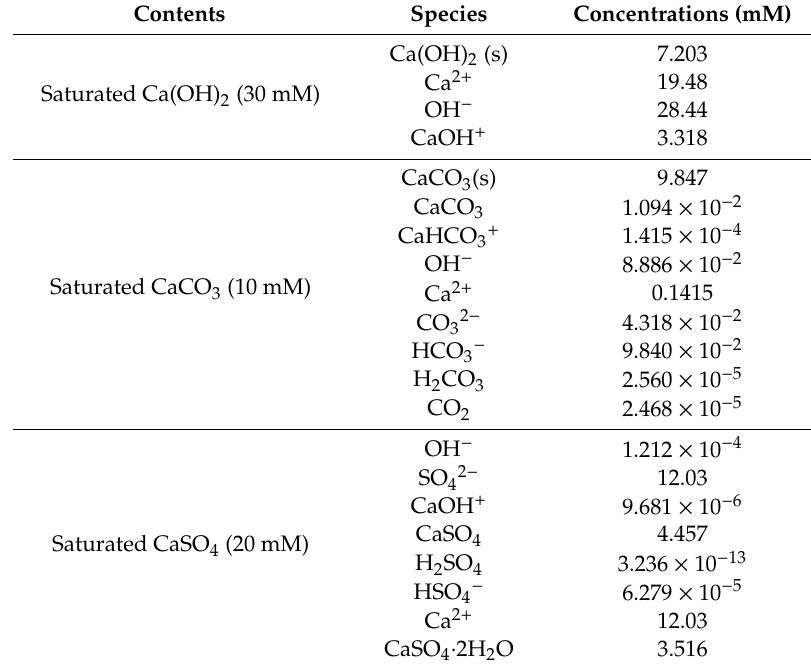
Table 3. Calculated equilibrium species distributions of the precipitation process and carbonation process, with and without filtration.